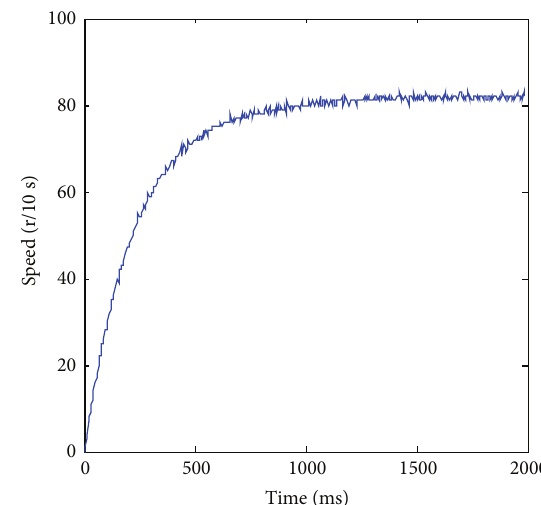
Figure 2: Relationship between the car’s speed and time.